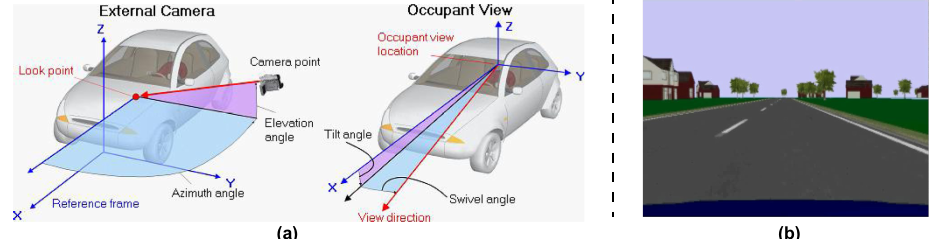
Figure 13. Carsim 8: camera point of view configuration ( a ) and camera front view ( b ).